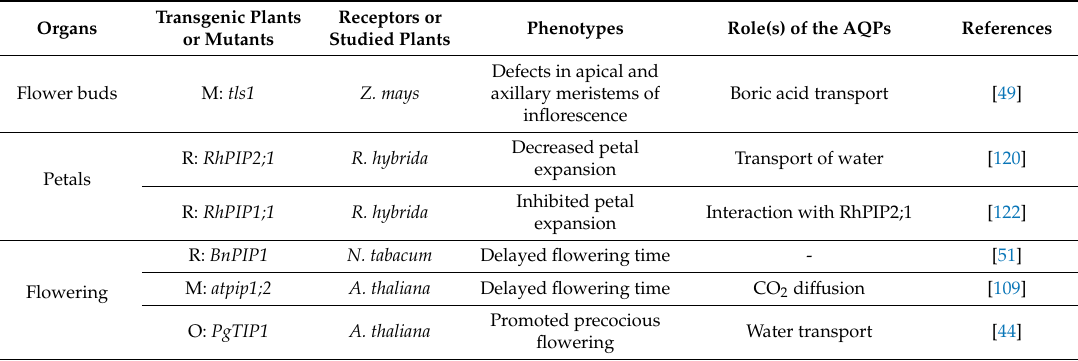
Figure 3. Roles of AQPs in petal expansion, anther dehydration, pollen development, hydration, germination, pollen tube elongation and seed development. ( a ) Roles of AQPs in petal cell expansion and flowering; ( b ) effects of NtPIP2 on anther dehydration and dehiscence; ( c ) AtTIP1;3, AtTIP5;1, AtNIP4;1, AtNIP4;2 and AtSIP2;1 play positive roles in the promotion of pollen hydration, pollen development, pollen tube elongation, and seed and silique development through facilitating the diffusion of water, urea and other small solutes. Arrows show positive regulation and bars show negative regulation. Table 2. The roles of AQPs during reproductive organ development.